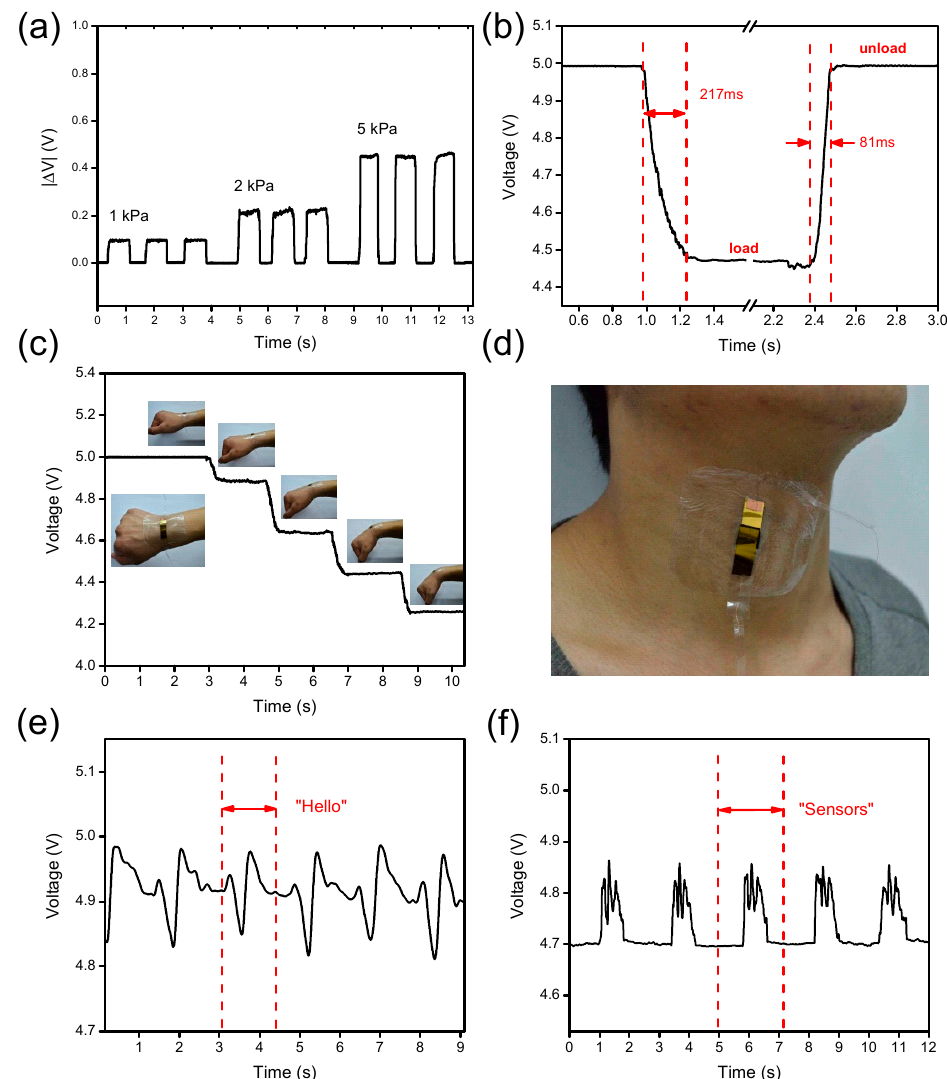
Figure 9. ( a ) Dynamic voltage variation under different pressures; ( b ) loading and unloading response times of the tactile sensor under 20 kPa pressure. ( c ) Detection for wrist bending with different angles. ( d ) Detection for muscle movement in speech. ( e , f ) Muscle movement signals monitored by the sensor when speaking a word repeatedly.